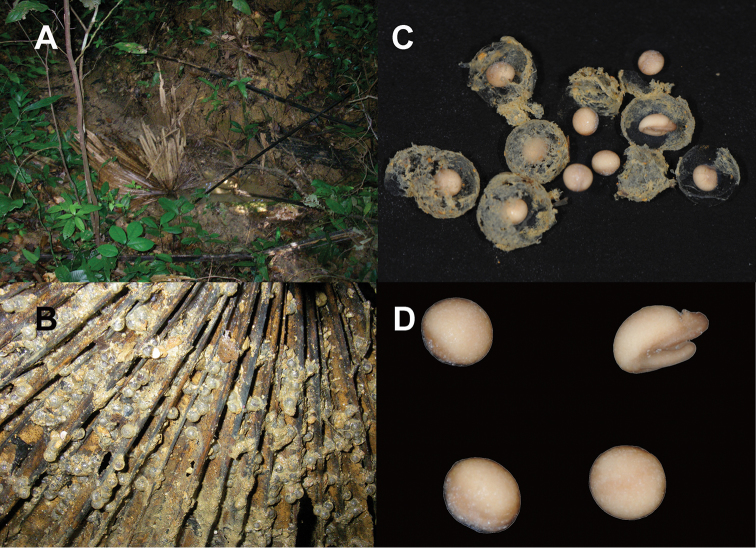
Limnonectessavan sp. nov. A oviposition site with dead palm frond in situ in Savannakhet Province, Laos B eggs (NCSM 76494) prior to preservation adhered to underside of dead palm frond that is visible in previous image C eggs (NCSM 76494) in preservative with jelly layer D eggs (NCSM 76494) in preservative after removal from jelly layer.